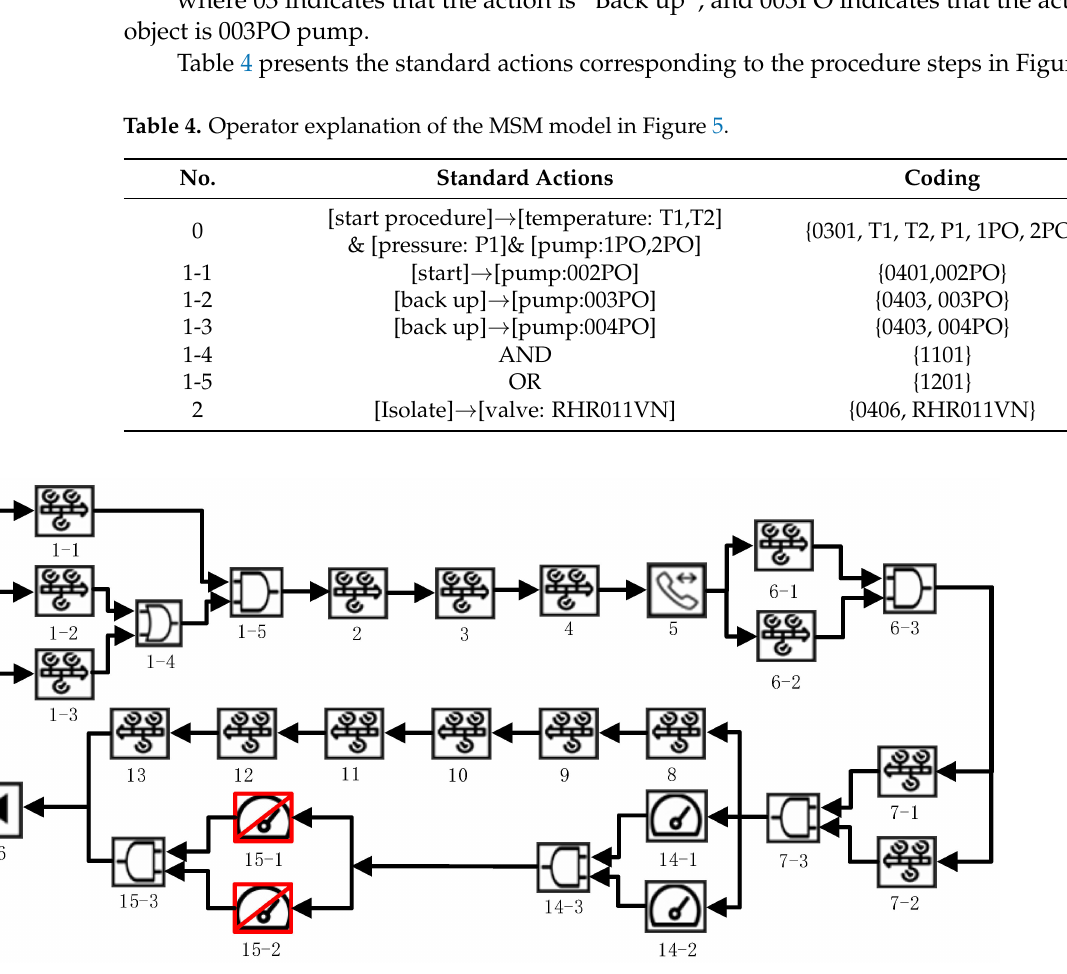
Figure 6. MSM model of RHR system